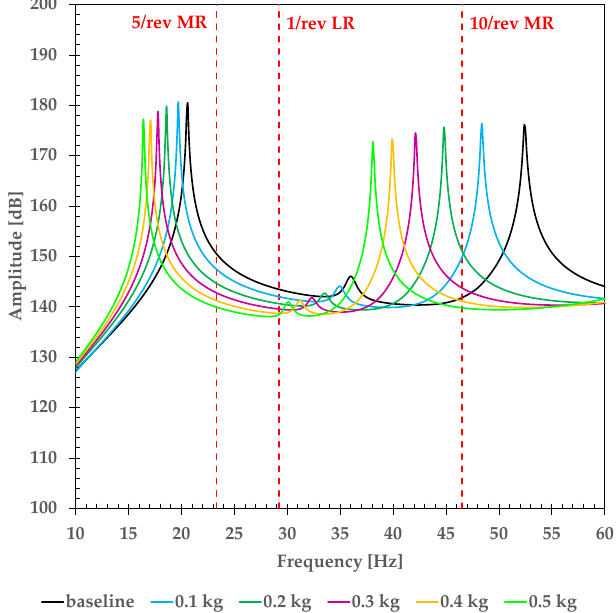
Figure 13. Tuning mass sensitivity on an MLG door.